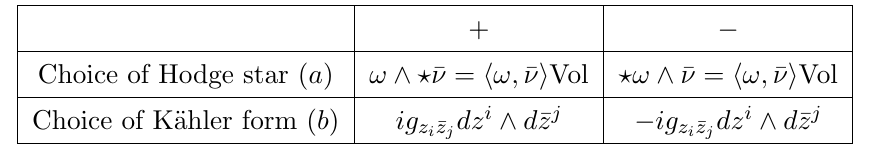
Table 1 . Possible conventions. The (cid:12)rst column denotes the quantity whose de(cid:12)nition can be chosen. The variables a and b in parentheses equal +1 if the choice corresponds to the second column and (cid:0) 1 if the choice corresponds to the third column. We have taken a = b = 1 throughout this